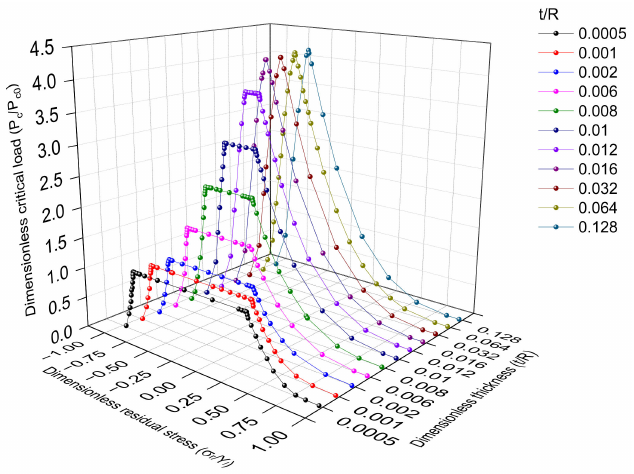
Figure 6. Dimensionless critical load versus dimensionless residual stress and dimensionless thickness for surface layer/substrate system pressed by a rigid hemisphere ( E s = E l = 200 GPa, Y s = Y l = 600